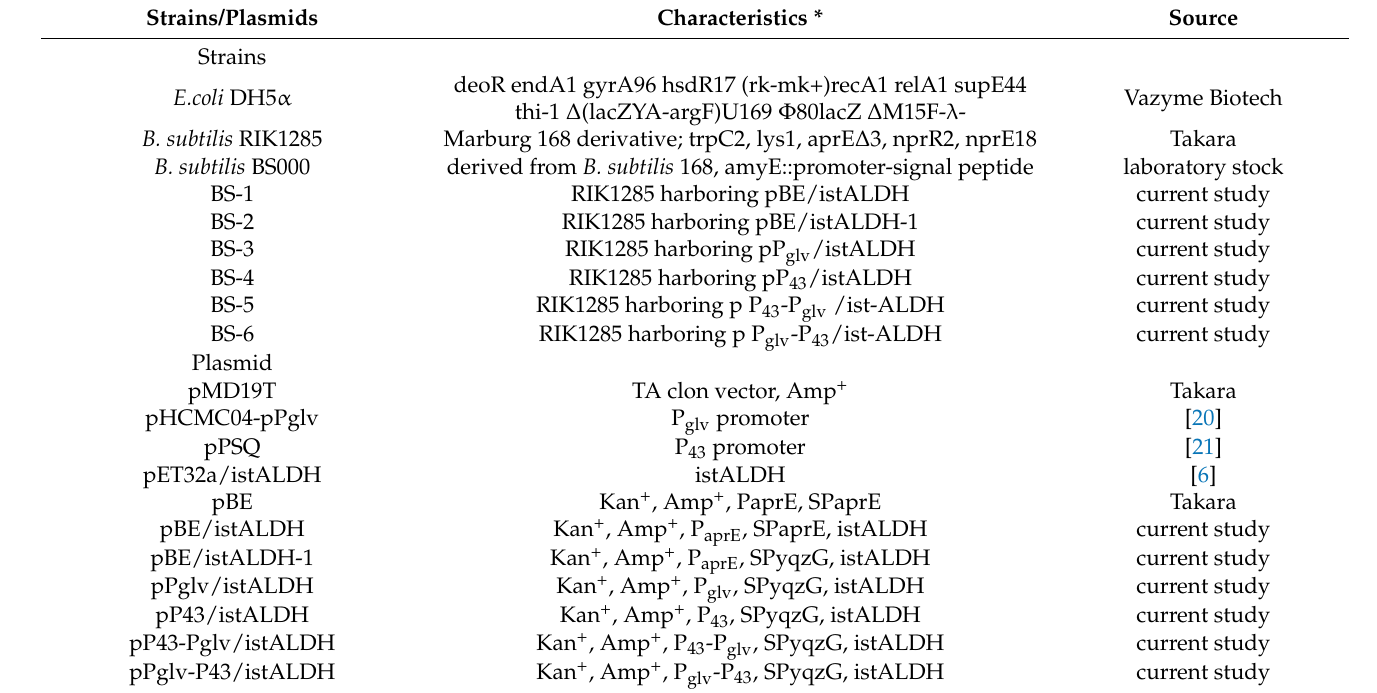
Table 1. Bacterial strains and plasmids used in this study.